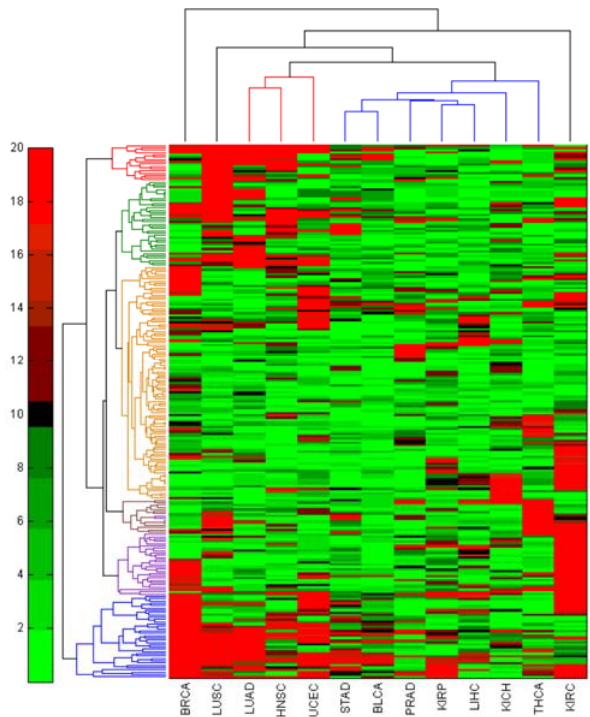
Figure 6. Hierarchical clustering analysis on significantly dys-regulated miRNAs in 13 TCGA (the Cancer Genome Atlas) cancer types. 233 arm-specific miRNAs were expressed in all 13 cancer types and further selected for hierarchical clustering analysis to reveal their significance in each cancer